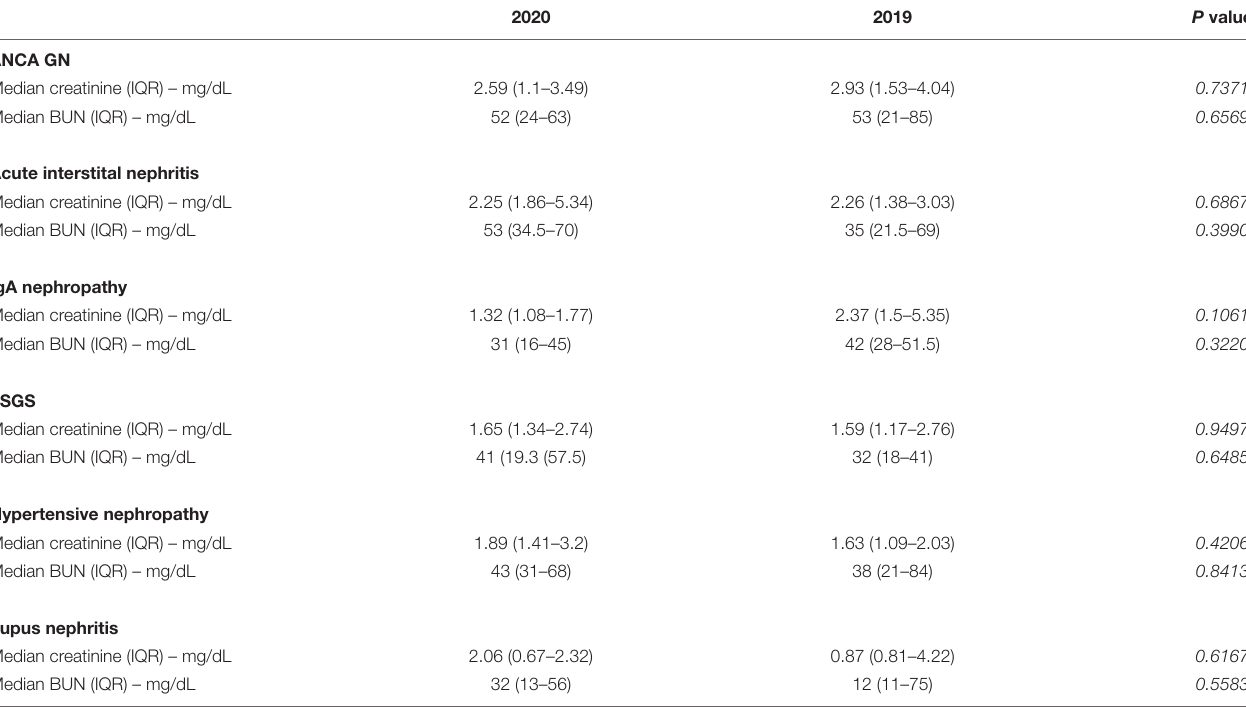
TABLE 6 | Laboratory findings at discharge in kidney diseases based on renal biopsies comparing 2020 with